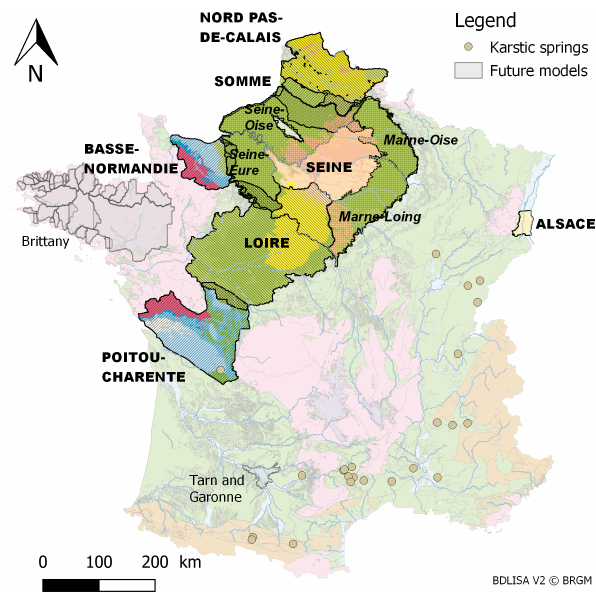
Figure 4. Map of the regional multilayer aquifers and the karstic systems simulated in AquiFR. The outlines of the models are also shown with colours corresponding to the outcropping aquifers with respect to their geological contexts. Grey areas correspond to mod- els that will be integrated in the near